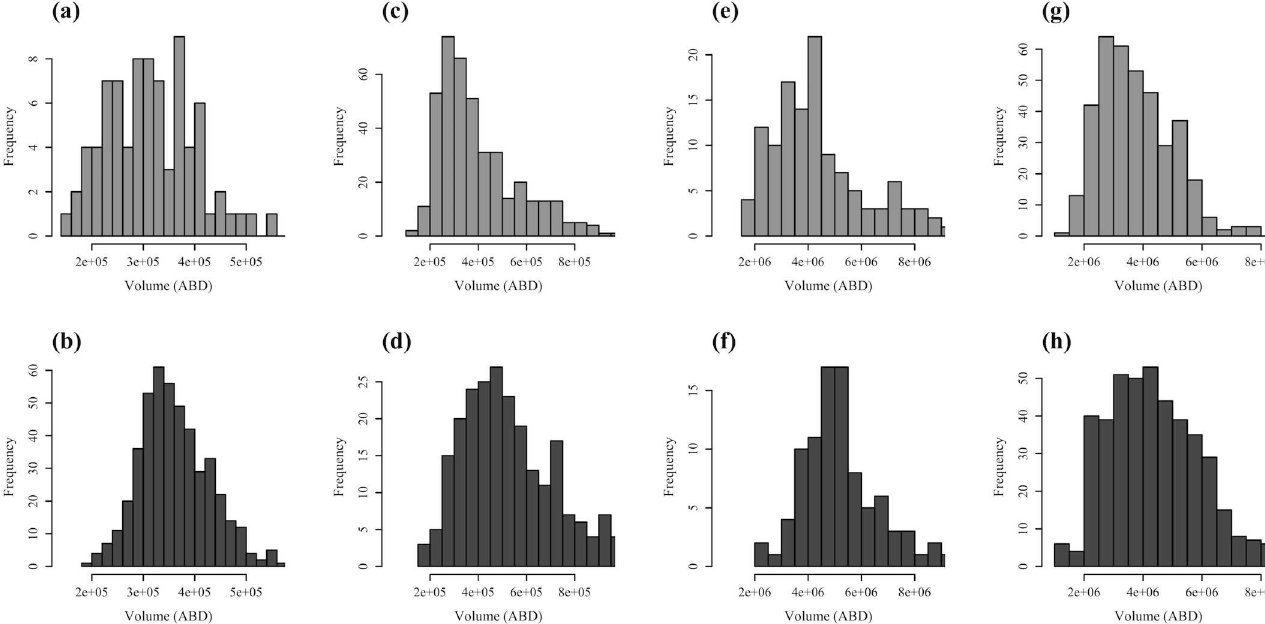
Fig 6. Examples of size distributions of various morphotypes based on volumes estimated from Area-Based-Diameter(V ABD ) from the modified FlowCAM procedure before and after incubation. Size distributions were measured before and after incubationfor (a, b) calanoid nauplii,(c, d) cyclopoidnauplii,(e, f) calanoidcopepodites, and (g, h) oithonidcopepodites. Bars denote biovolumefrequency. https://doi.org/10.1371/journal.pone.0175235.g006 Table 2. Comparison of FlowCAM image analysis versus microscope